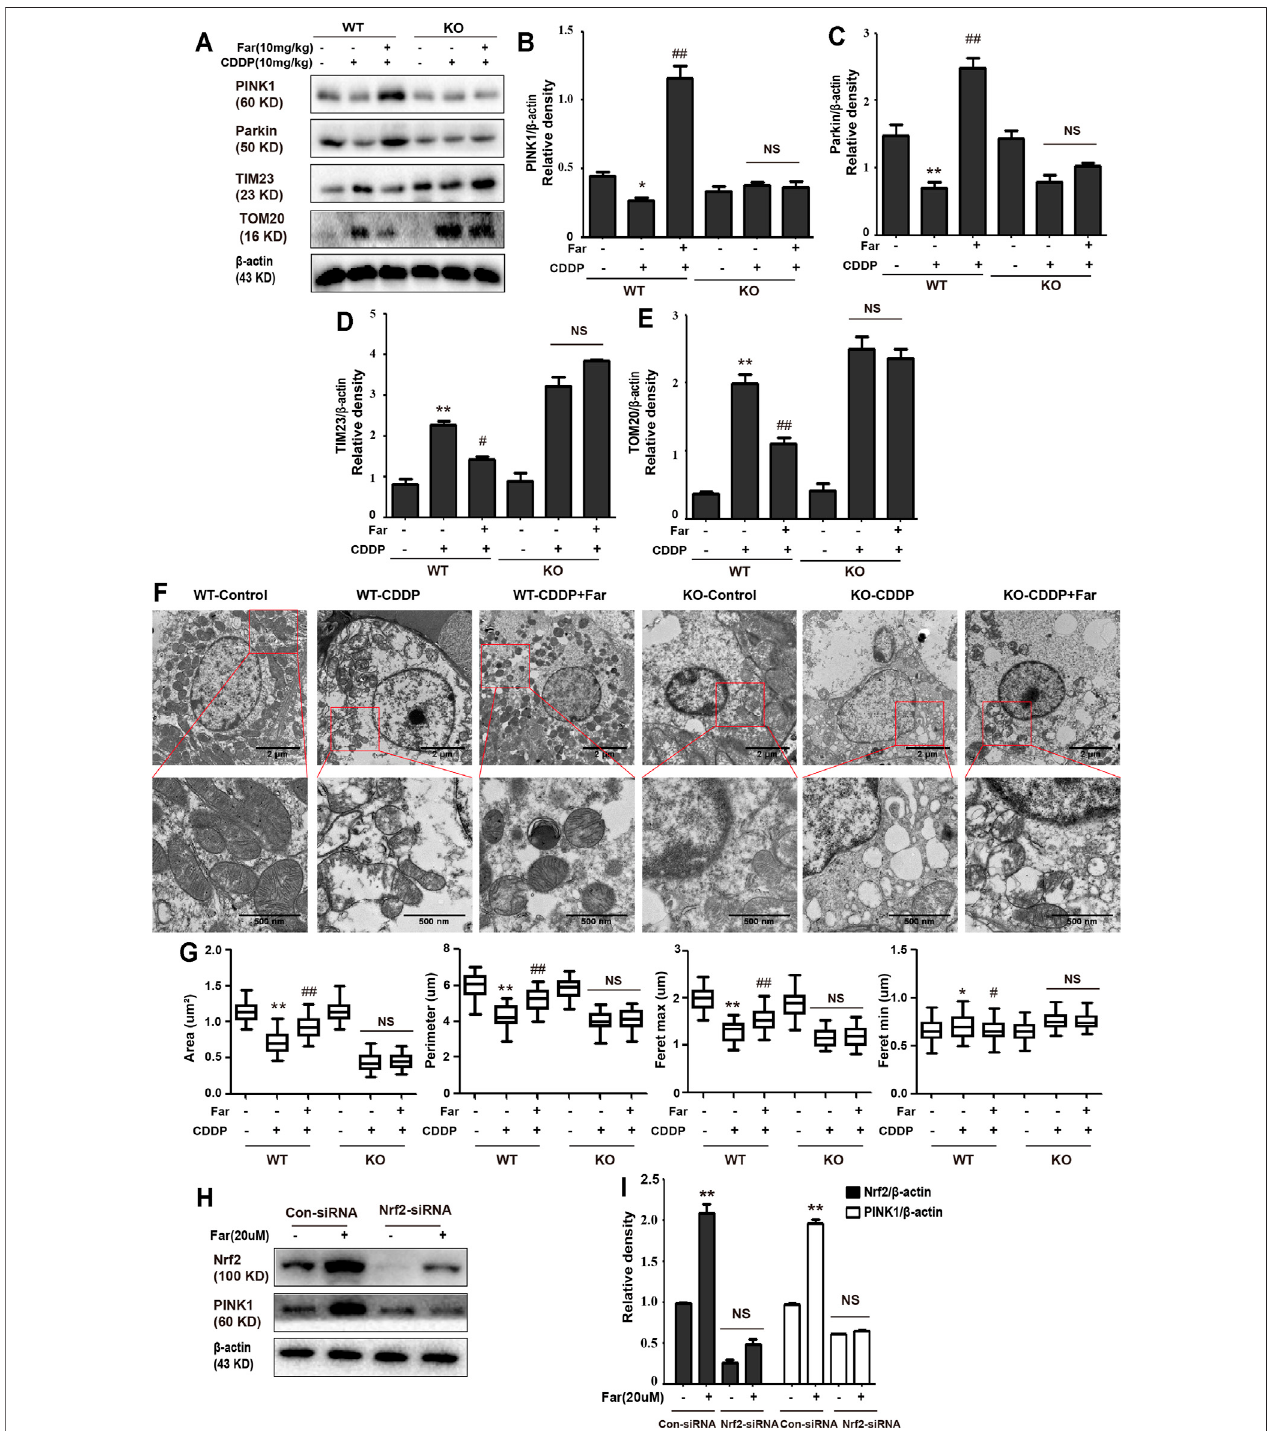
FIGURE 8 | Knockdown of Nrf2 partially abolishes PINK1/Parkin-mediated mitophagy activated by farrerol pretreatment in mice. The expression levels of the mitophagy-mediating proteins PINK1, Parkin, TIM23 and TOM20 in wild-type and Nrf2 knockout mice were investigated by Western blotting (A) and analyzed by densitometryanalysis (B – E) . (F) RepresentativeTEMimagesofmitochondrialmorphologyinkidneytubularepithelialcellsofwild-typeandNrf2knockoutmice. (G) Data were shown as quanti fi cation of mitochondrial contour measurements from n (cid:1) 6 mice per group. Data are expressed as the mean ± SEM. (H, I) HK-2 cells were transfected with a Nrf2 siRNA or Nrf2-negative control siRNA for 72 h and exposed to farrerol (20 μ M)for 24 h, and the protein levels were subsequently detected with westernblotting.Thelevels ofNrf2andPINK1weredetermined.* p < 0.05and** p < 0.01comparedwiththecontrolgroup; # p < 0.05and ## p < 0.01compared withthe CDDP group. NS, no speci fi city. β -actin was used as an internal control.